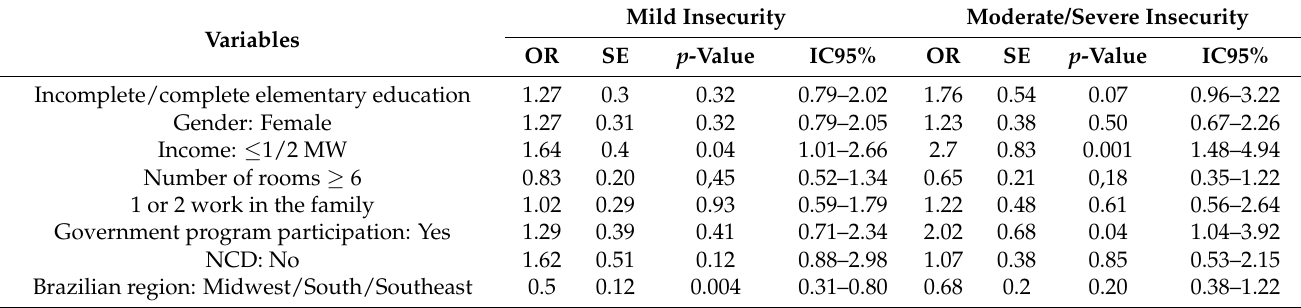
Table 3. Multivariate multinomial logit model for predictors of Household Food Security Situation (reference group: food security) in food handlers of community